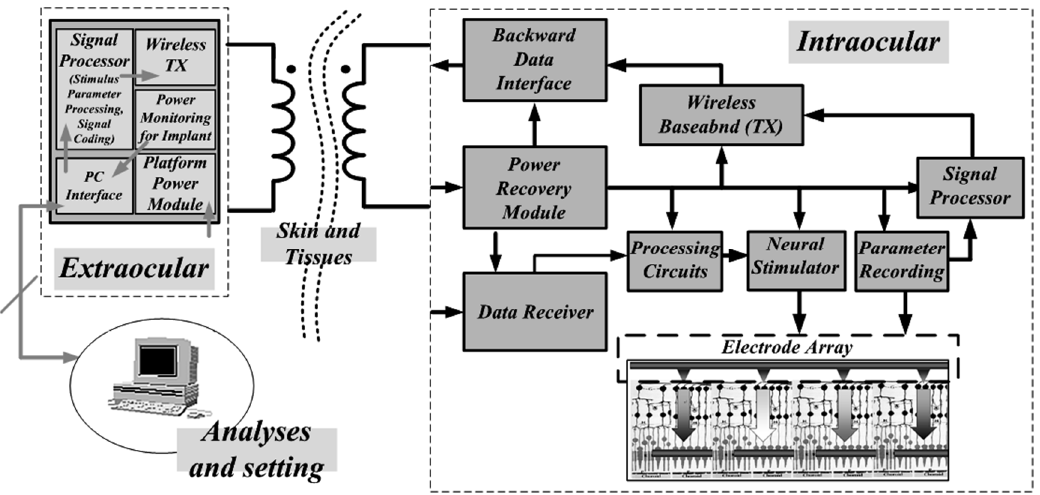
Figure 2. Wireless implantable system architecture for a Retinal Electronic Prosthesis with an external PC used to analyze various physiological and environmental parameters taken from intraocular sensor records.